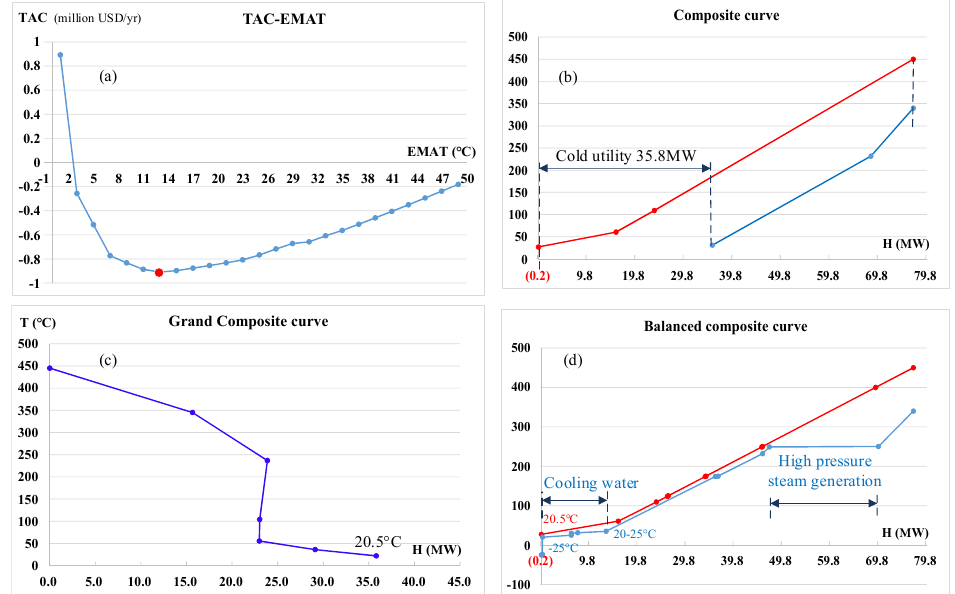
Figure 6. ( a ) TAC vs. ∆ T min , ( b ) cold and hot composite curves, ( c ) grand composite curve, and ( d ) balanced composite curve of APU. (Note: in figures ( b , d ), red line represents hot compound curve; blue line represents cold compound curve.)